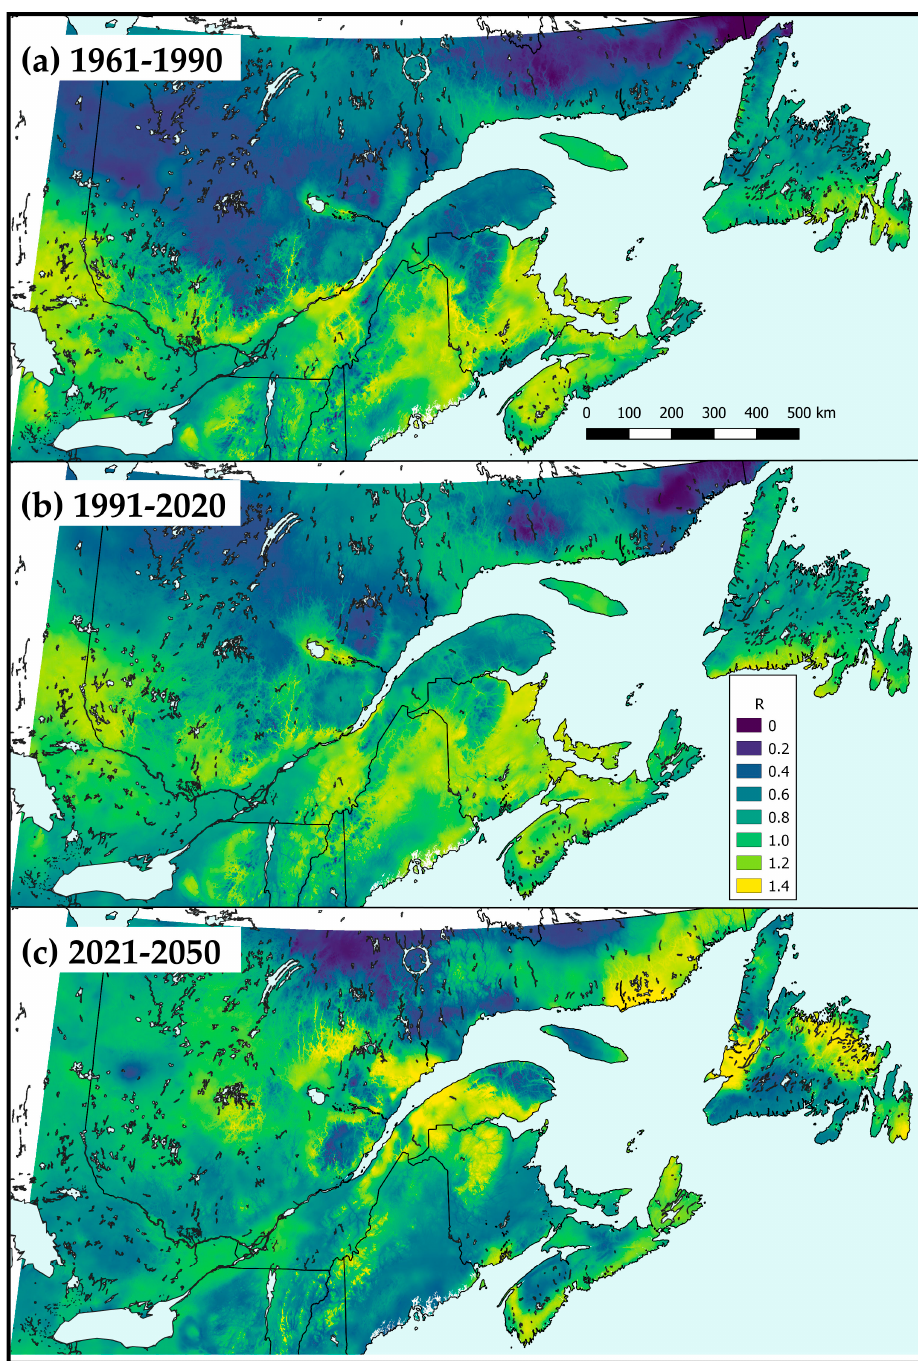
Figure 7. Maps of annual population growth rate of Actia interrupta over northeastern North America, using ( a ) observed 1961–1990 weather; ( b ) observed 1991–2020 weather; and ( c ) 2021–2050 randomized daily from normals of IPCC’s greenhouse gas emission scenario RCP 4.5.